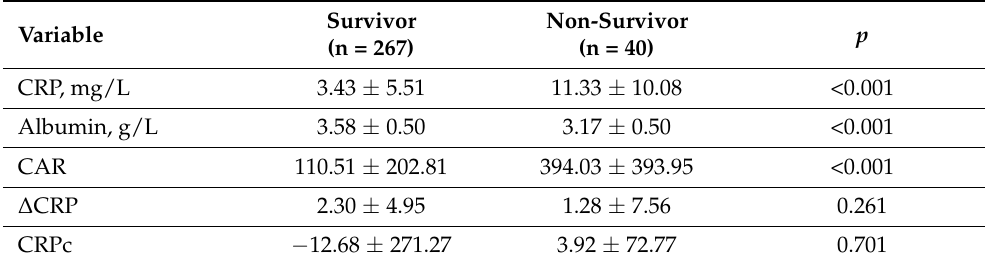
Table 2. Comparison of serum CRP and albumin levels between survivors and non-survivors. Variable